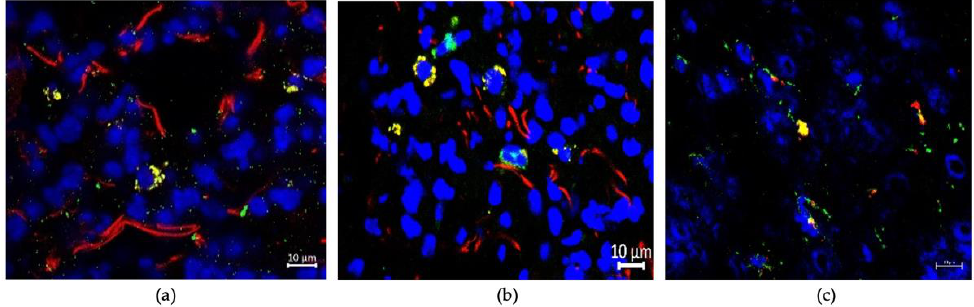
Figure 9. Analysis of EV-uptaking cell types in the lung ( a , b ) and the liver ( c ). Representative fluorescence images of the lung ( a , b ) and the liver ( c ) 12 h after i.v. injection of PKH26-labeled VCaP EVs with simultaneous staining of the epithelial cell marker EpCAM ( a ) and the macrophage marker F4-80 ( b , c ). EpCAM and F4-80 are labeled green with the use of specific antibodies, EVs appear in red, cell nuclei in blue. Yellow signals indicate a colocalization of EVs with the stained marker. Resolution 1000-fold; scale bar = 10 μm.